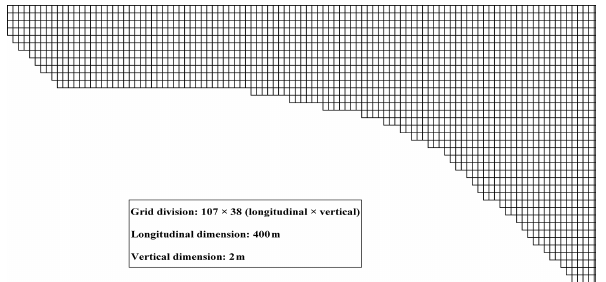
Figure 2. Grid structure of the research